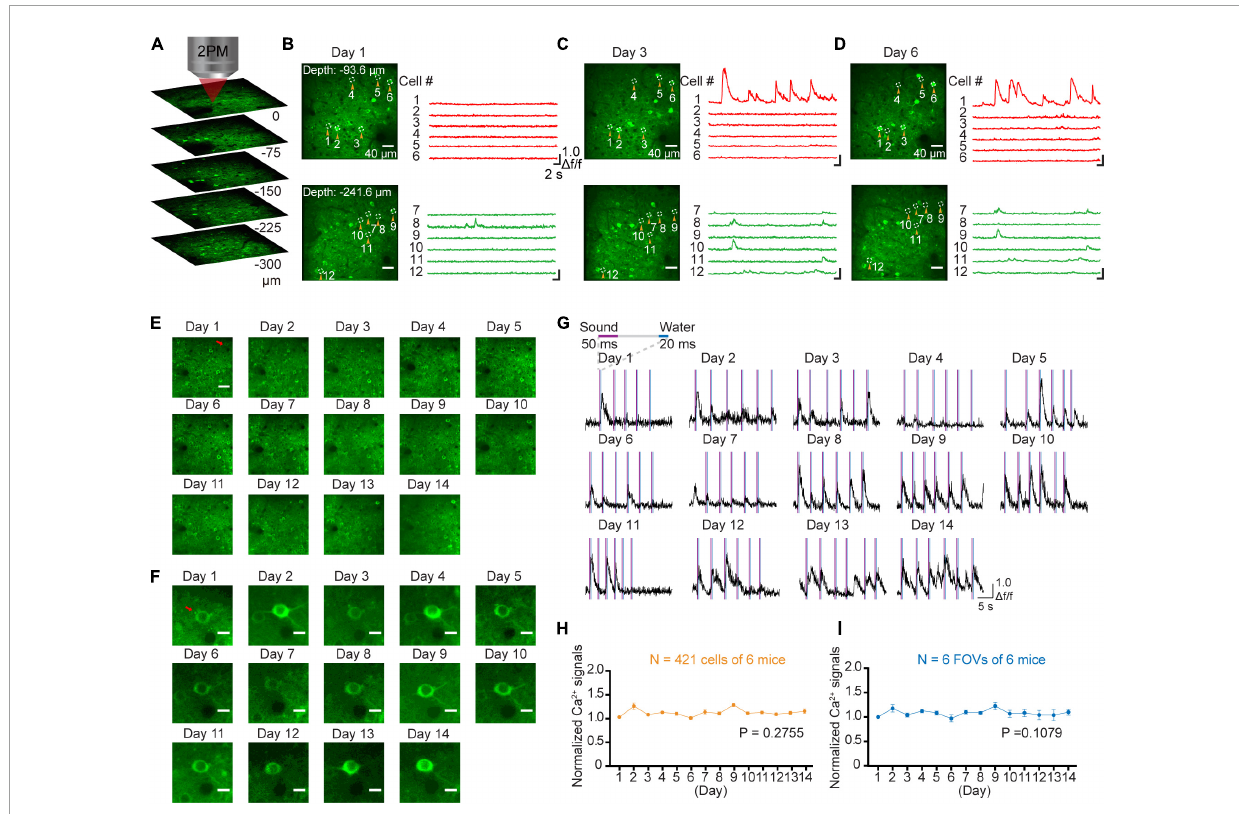
FIGURE3 Stable long-term chronic two-photon imaging. (A) 3D reconstruction of population neurons labeled by the GcaMP6m-XC virus in AuC. (B) Two photon imaging in AuC at different depths on day 1. (C) Two photon imaging in the same FOVs (in panel B ) on day 3. (D) Two photon imaging in the same FOVs (in panel B ) on day 6. (E) Daily two-photon chronic imaging of AuC neurons labeled by GCaMP6m-XC virus across as long as 14 days. Scale bar: 40 µ m. (F) Daily two-photon chronic imaging of an example magnified neuron out of panel (E) across 14 days. Scale bar: 5 µ m. (G) Ca 2 + signals of an example neuron by expressing GCaMP6m-XC virus across as long as 14 days. (H) Comparison of normalized Ca 2 + signals of population neurons during chronic two-photon imaging. (421 cells from 6 mice), P = 0.2755, one-way ANOVA test. (I) Comparison of normalized Ca 2 + signals of field of view during chronic two-photon imaging (6 FOVs from 6 mice). There was no significant difference in daily Ca 2 + signals during imaging, P = 0.1079, one-way ANOVA